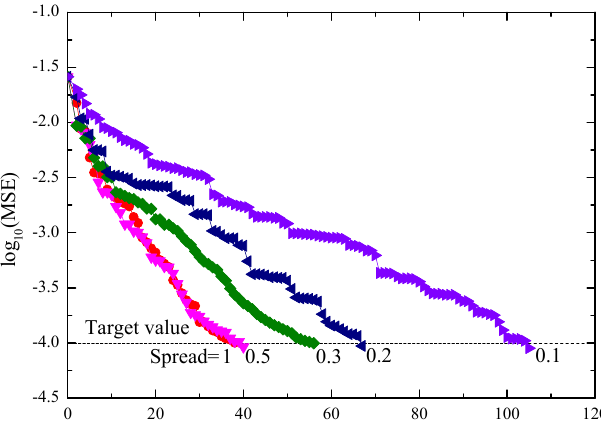
Figure 4. The relationships of mean square error (MSE) and the number of hidden layer neurons with different Spreads. Table 2. Performance evaluation of RBF neural networks with different Spreads.